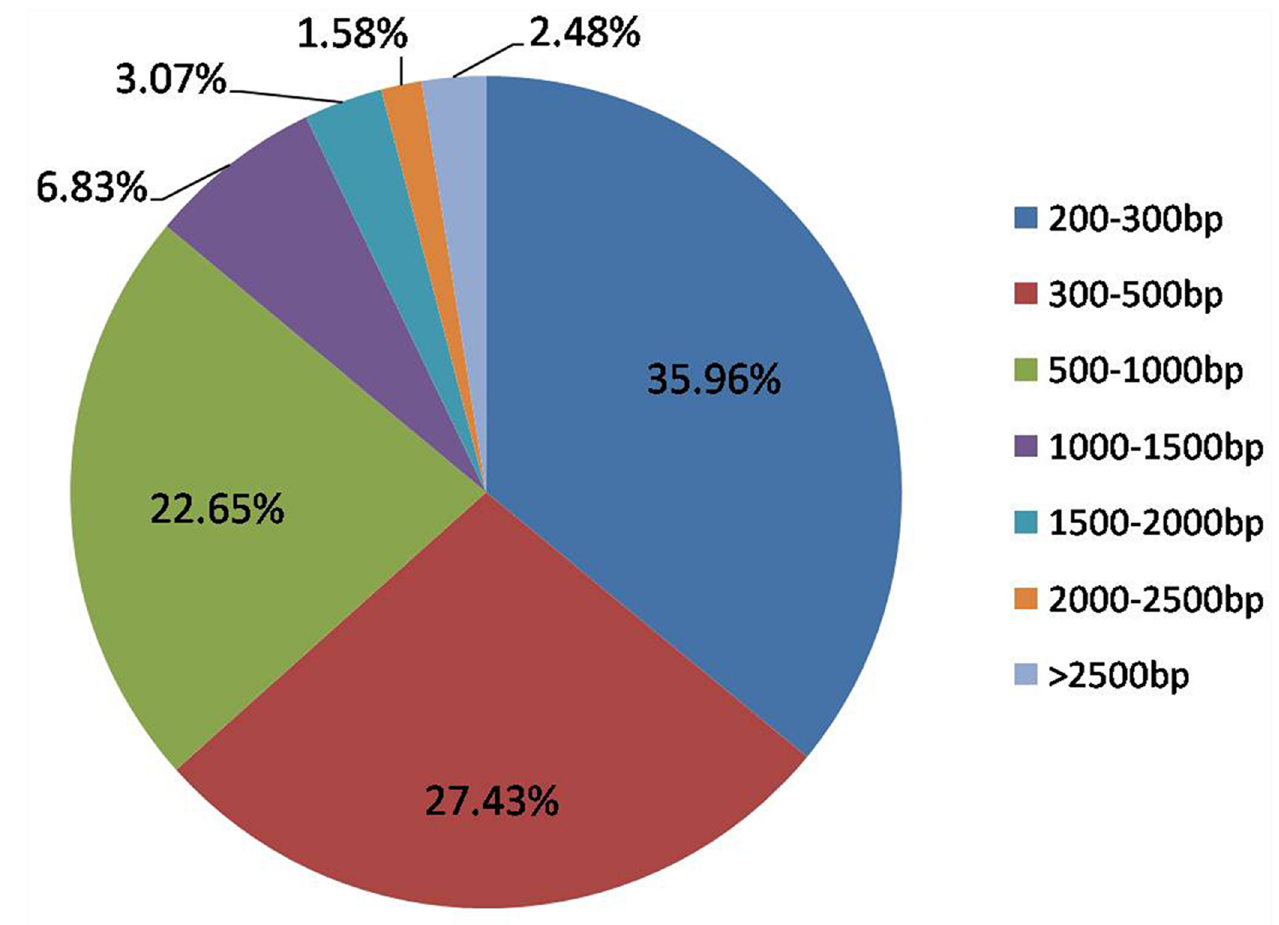
Fig 1. Distribution of unigene lengths in the B . tabaci transcriptome. De novo assembly of RNA-seq data produced 292,696 unigenes between 201 – 28,036bp in length.